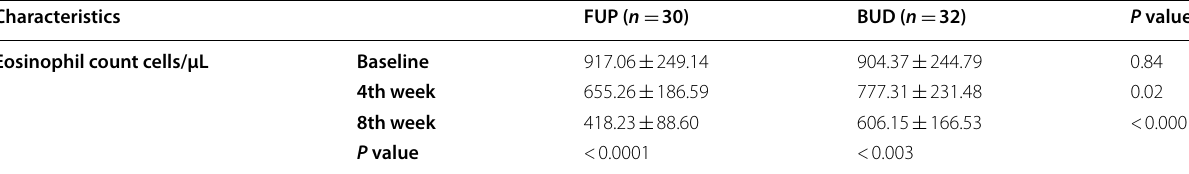
Data are shown as mean standard deviation as appropriate ± FUP Fluticasone propionate, BUD Budesonide